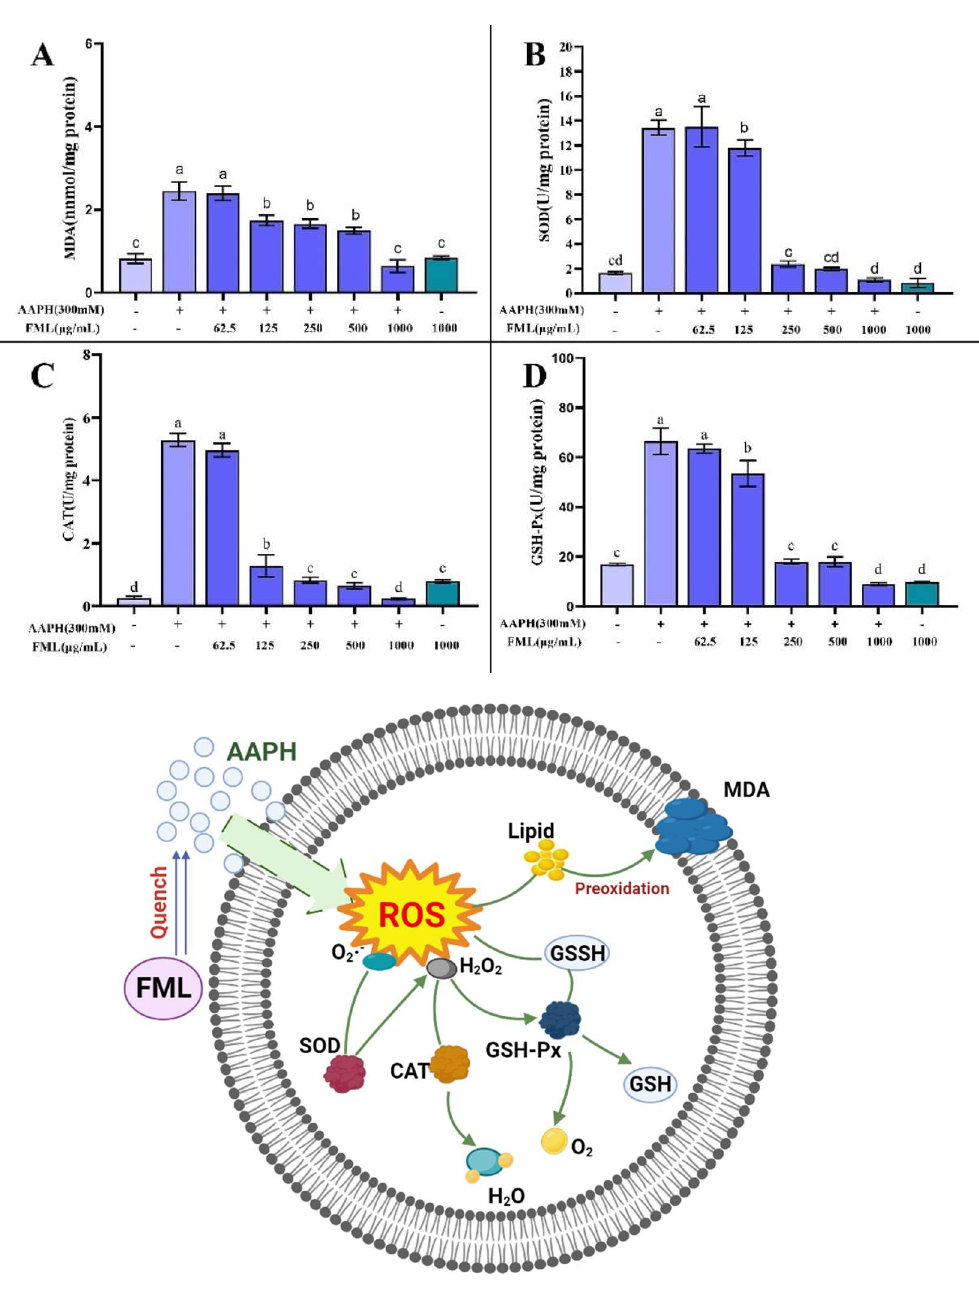
Figure 9. Effect of FML on changes in MDA content ( A ) and enzyme activities of SOD ( B ), GPx ( C ), and CAT ( D ) in erythrocytes with AAPH-induced oxidative damage; ( E ) possible intracellular antioxidant mechanisms of FML in an AAPH-induced model of oxidative damage (Note: The same small letters indicate no significant difference between groups, different small letters indicate a significant difference between groups, p < 0.05).